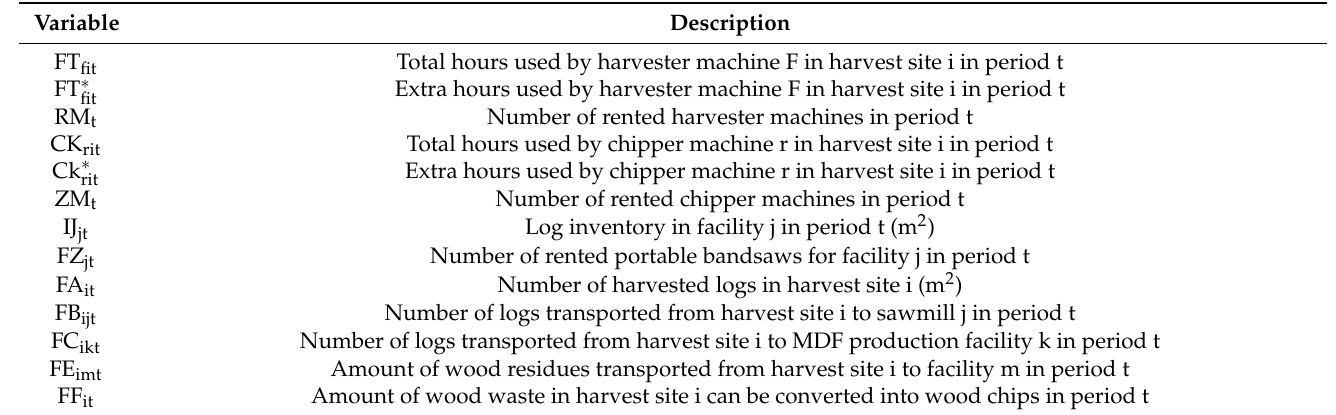
Table 3. Variables of mathematical